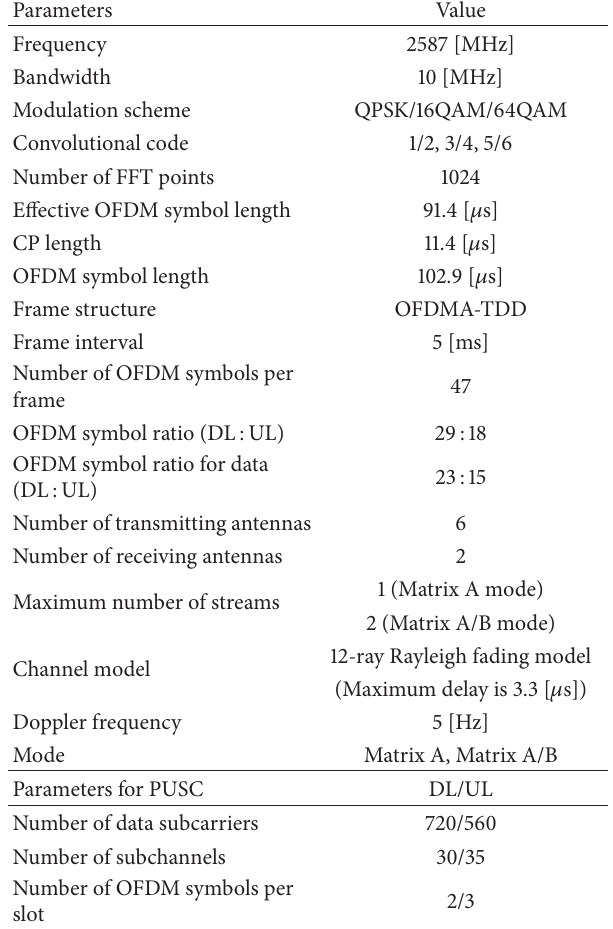
Table 1: Parameters for experimental mobile WiMAX